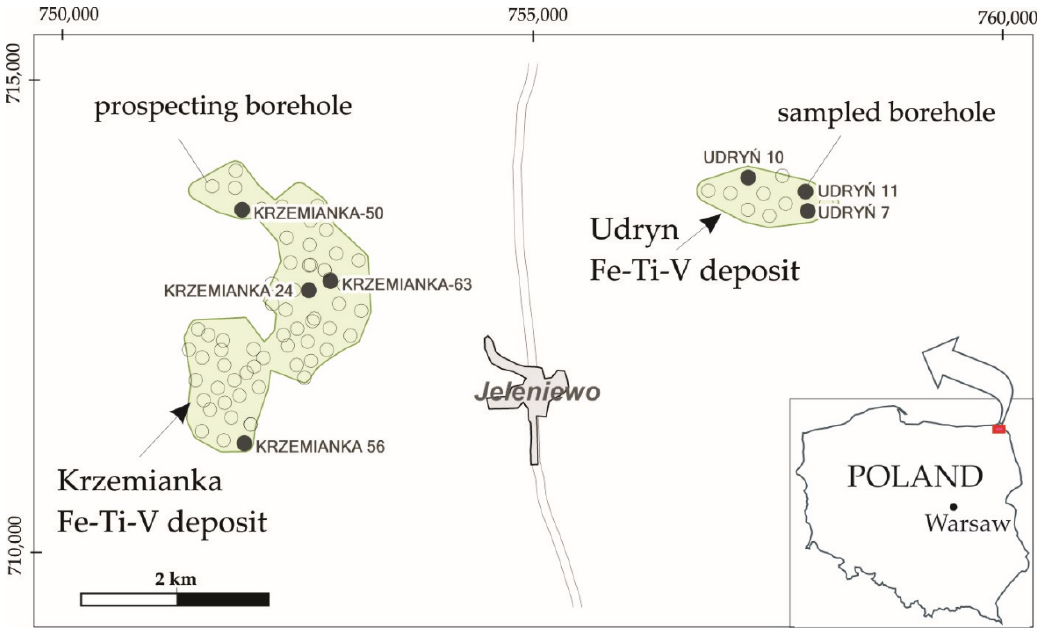
Figure 4. Location of boreholes sampled and studied in the Krzemianka and Udryn Fe-Ti-V deposits in NE Poland. Note: the boundaries of the deposits are projected onto the ground surface.